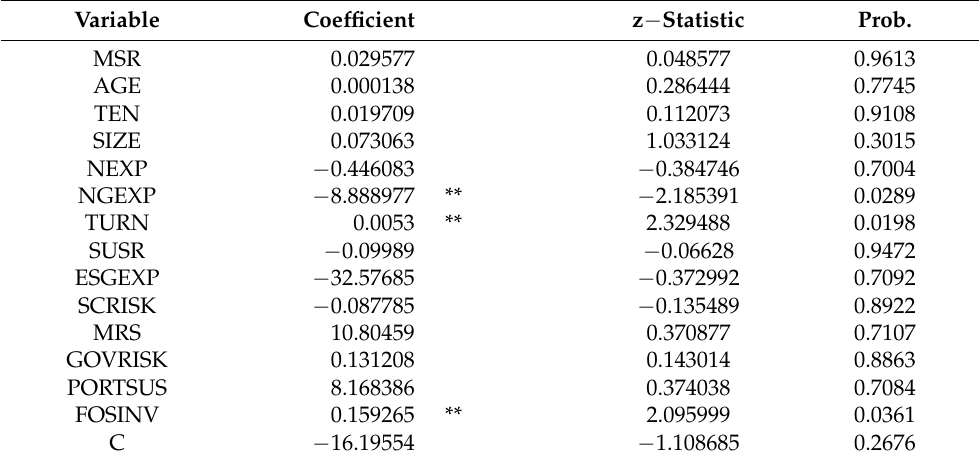
Table 6. Impact of fund characteristics on the volatility transmission from oil price to mutual fund flows. Variable z − Statistic